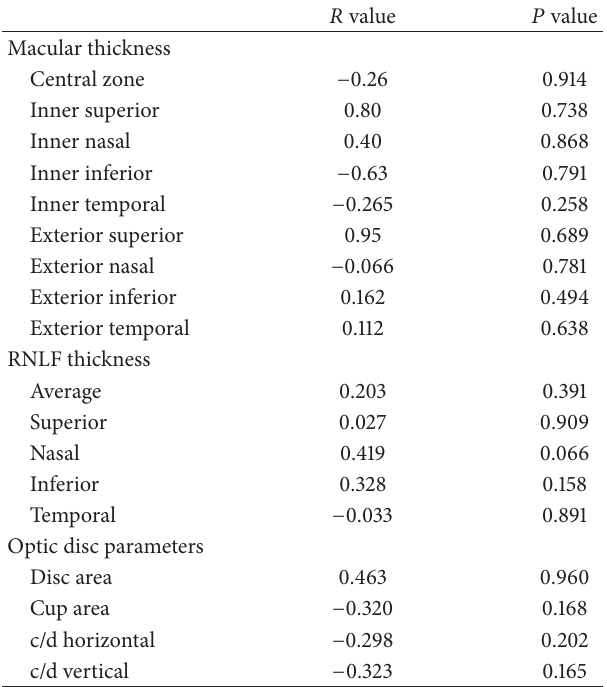
Table 2: Correlation between refractive error and OCT parameters in amblyopic